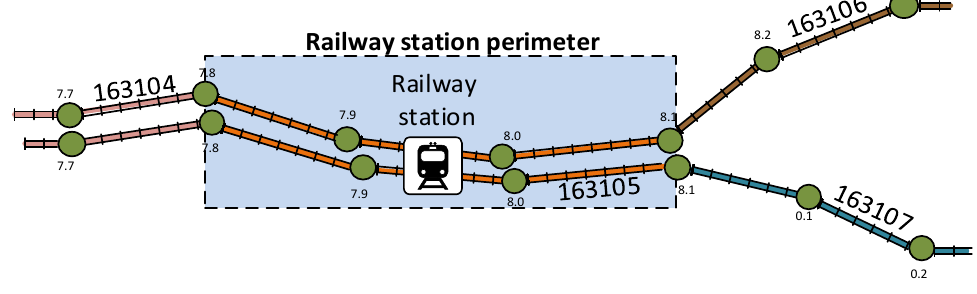
Figure 5. Demonstration of TUDU change on the track. Author ´ s